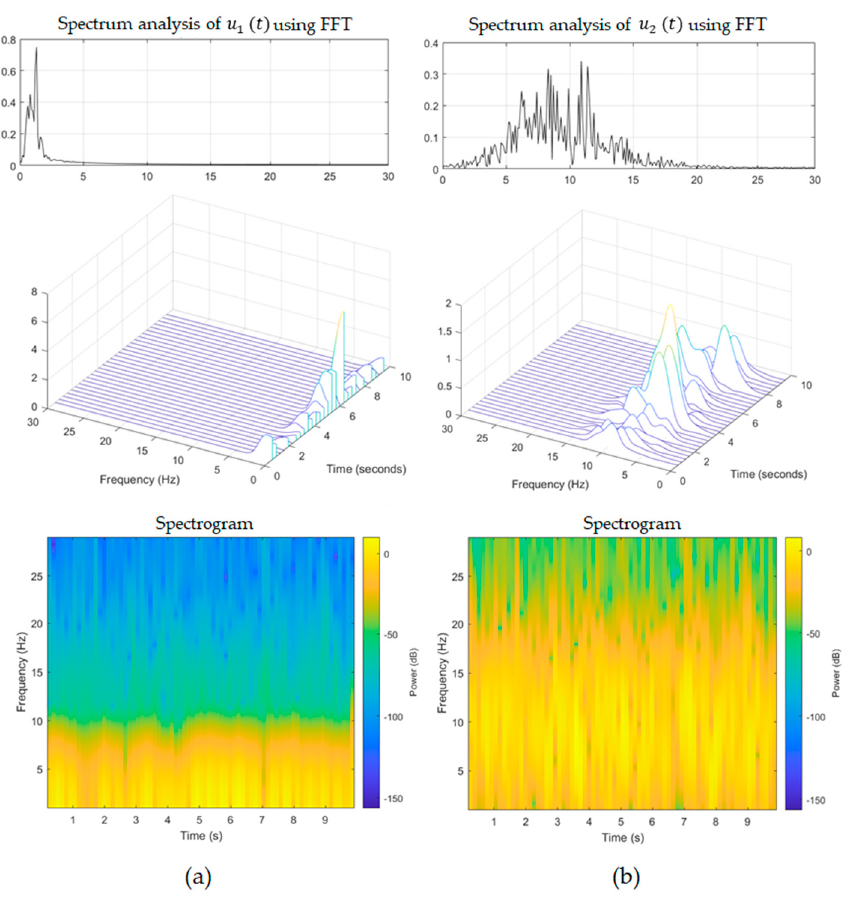
Figure 10. Spectrum analysis of the selected signals and their spectrogram for ( a ) u 1 ( t ) signal, ( b ) u 2 ( t )